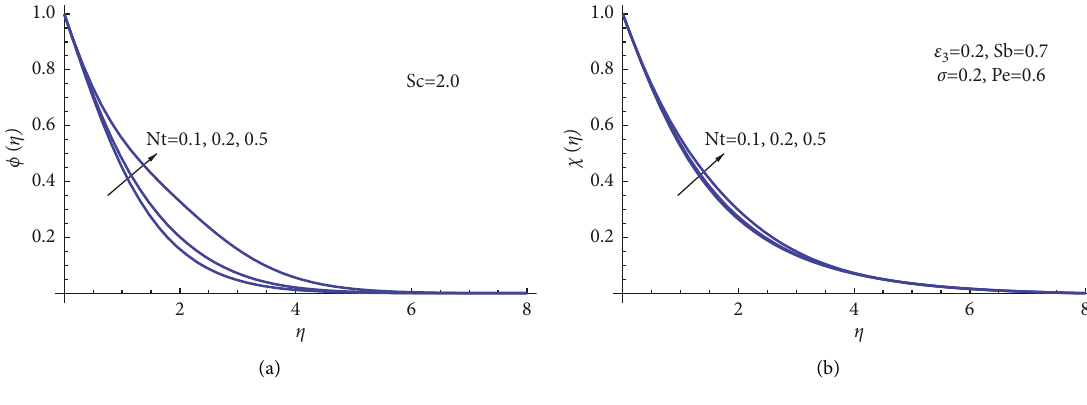
Figure 7: (a) Impact of Nt on ϕ ( η ) . (b) Impact of Nt on χ ( η ) .